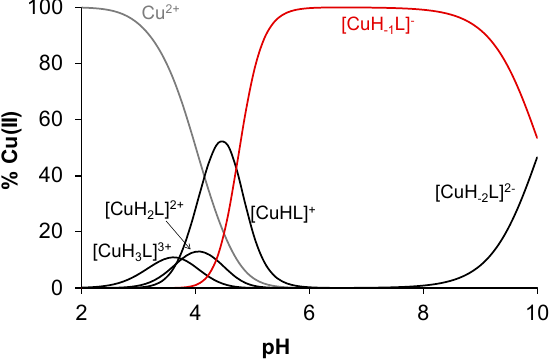
Figure 1. Concentration distribution curves for the copper(II)-DAHK (1:1) system. { c DAHK = c Cu(II) = 1 mM; 30% ( w / w ) DMSO/H 2 O; T = 25 ◦ C; I = 0.10 M